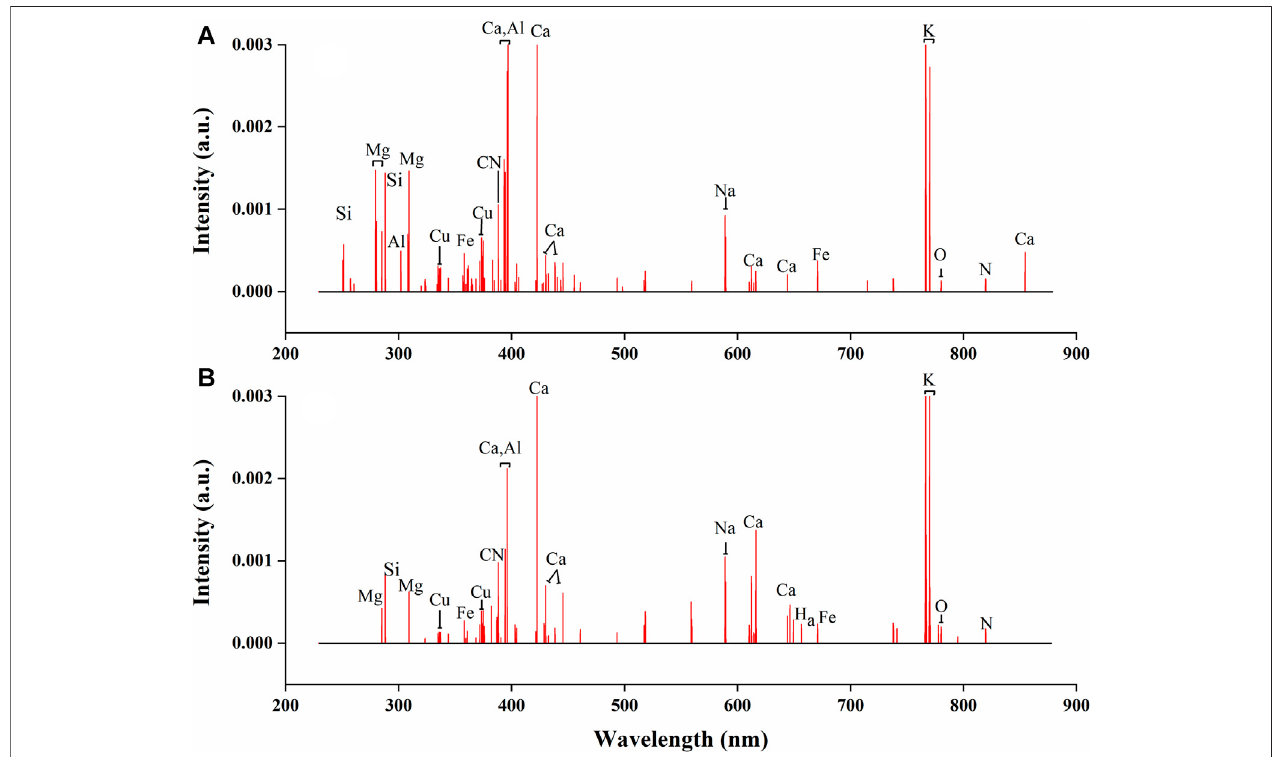
FIGURE 6 | The selected variables by VIM using RF in LIBS spectra for (A) underground parts and (B) aerial parts of G. rigescens Franch.